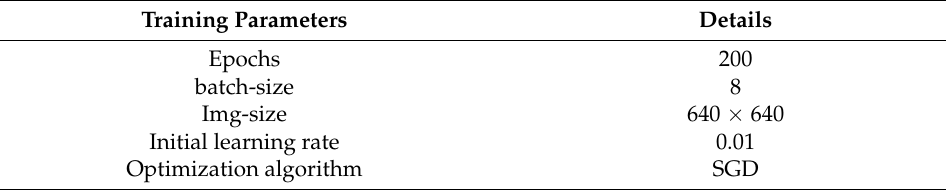
Table 2. Training parameters setting for improved forest fire detection model.